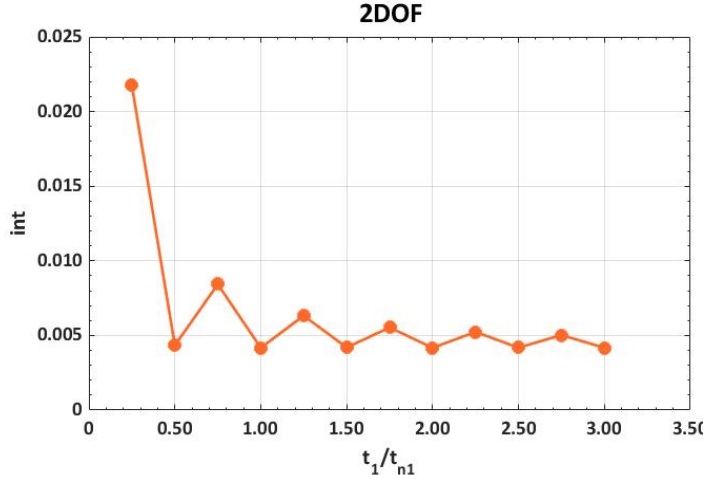
Figure 5. Cost function int with respect to the adimensional time τ for the 2DoF model.